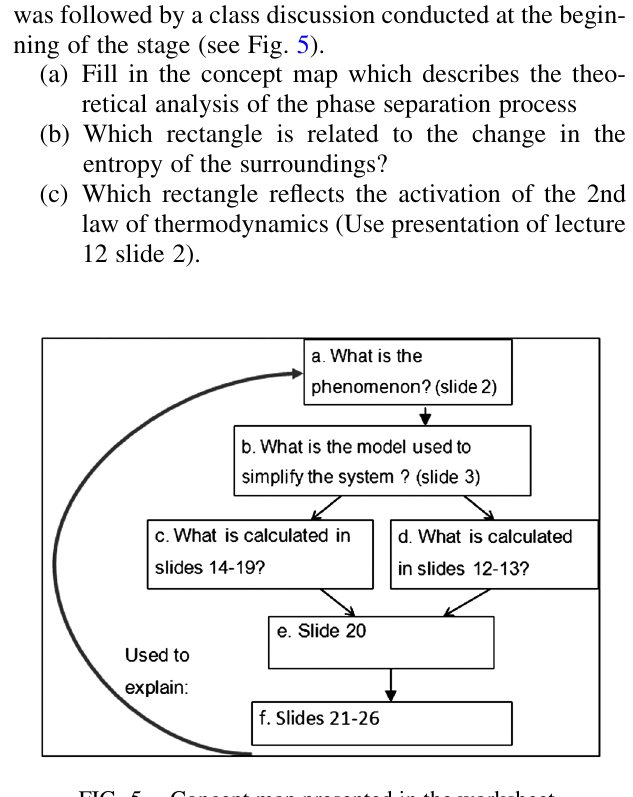
FIG. 5. Concept map presented in the